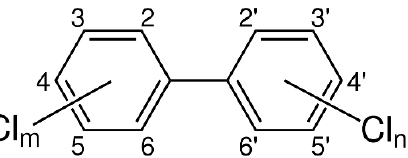
Figure 1. Chemical structure of PCBs (m and n denote number of chlorine atoms on each ring).